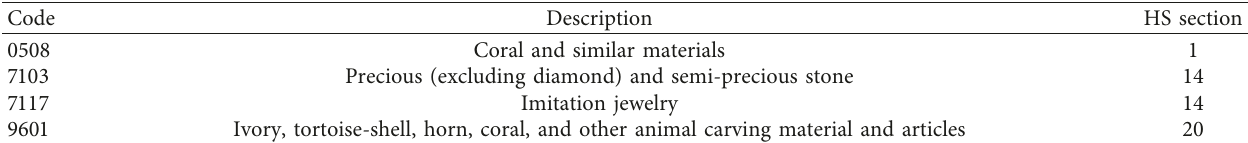
Table 1: Example of exported products by firm A. Clearly, this firm deals with jewelry and corals and in the last 20 years it exported these products for about 10 million euros.